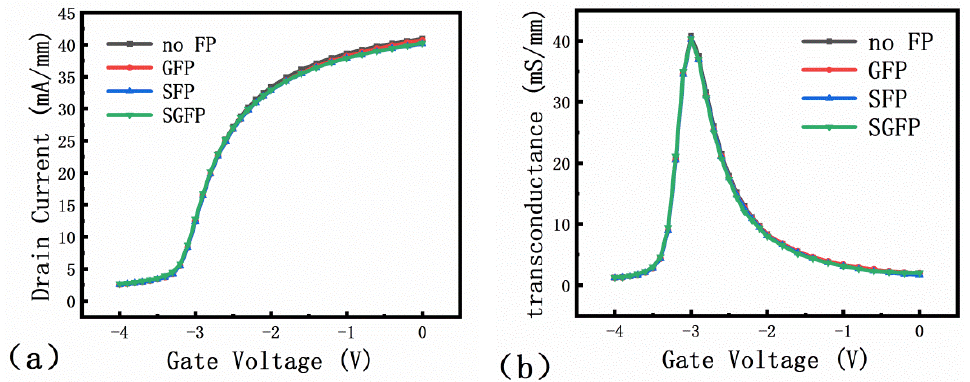
Figure 4. Simulation of ( a ) transfer characteristic curves and ( b ) transconductance for different field plate types.